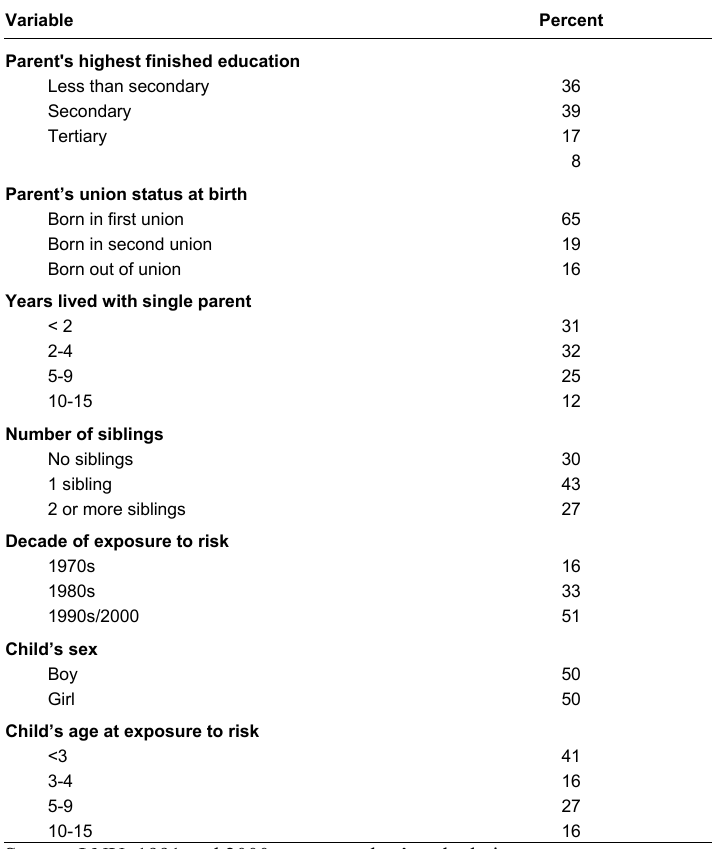
Descriptive statistics: Independent